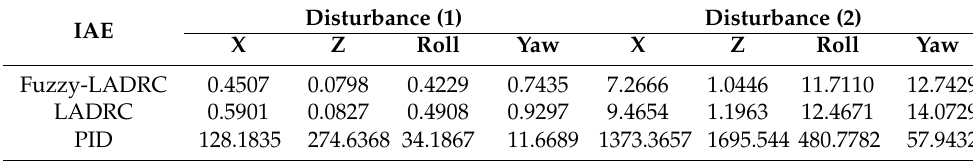
Table 6. Disturbance experiment results under two kinds of disturbance